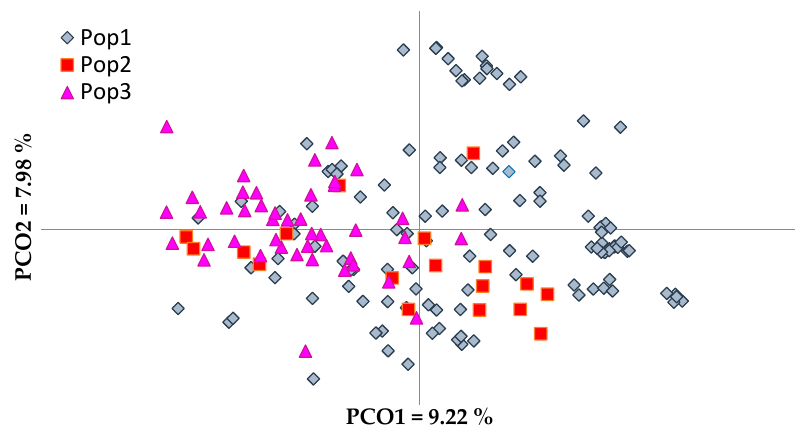
Figure 1. Principal coordinate analysis (PCoA) of olive genotypes based on their origin and breeding.